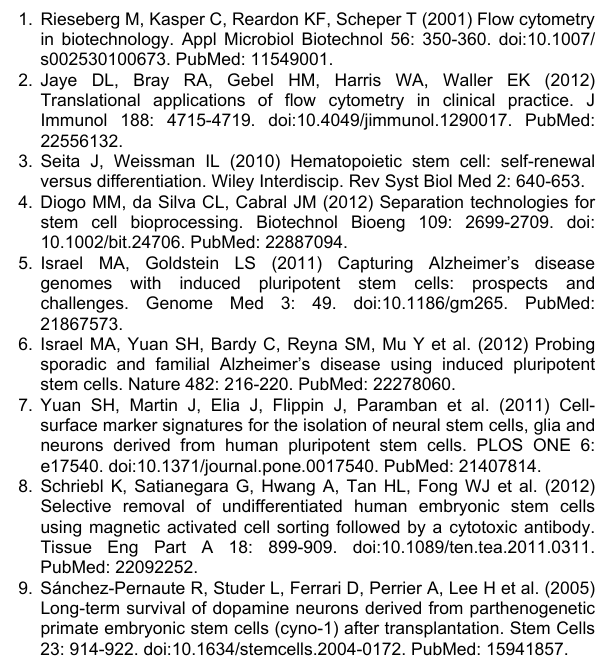
Figure S2. Effects of fixation and permeabilization on forward and side scatter fluorescence signal. Incubation with fixative and permeabilization buffers as indicated alters flow cytometric forward and side scatter properties (SH-SY5Y cell line). Adjusting FSC resolution (arrows) enables proper visual representation and subsequent analysis of the overall population (far right column of panels). permeabilization with either detergent. Mean fluorescence intensity (MFI) of a single representative experiment is shown. fixable red-fluorescent live/dead labeling dye.